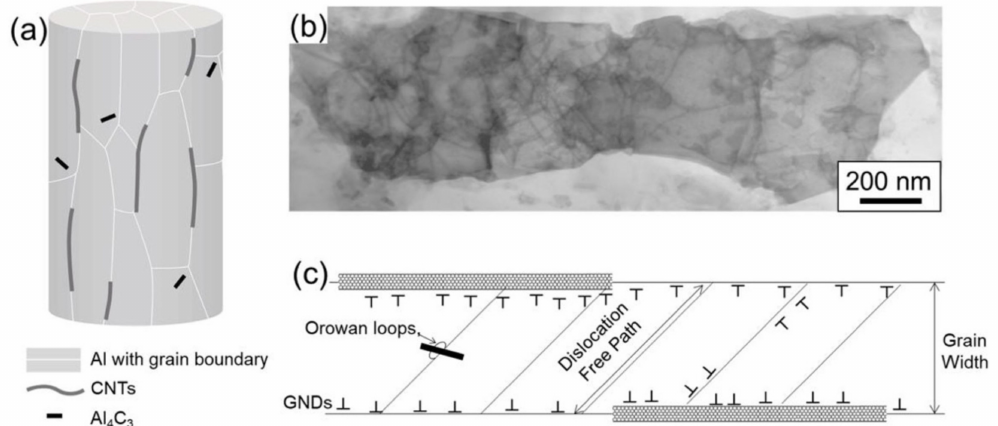
Figure 19. ( a ) Illustration of the microstructure of Al/CNT composites; ( b ) bright-field scanning TEM (STEM) image of an Al grain in 2% Al/CNT after break; ( c ) illustration of the dislocation behavior. Reproduced from [101] with permission from Elsevier,